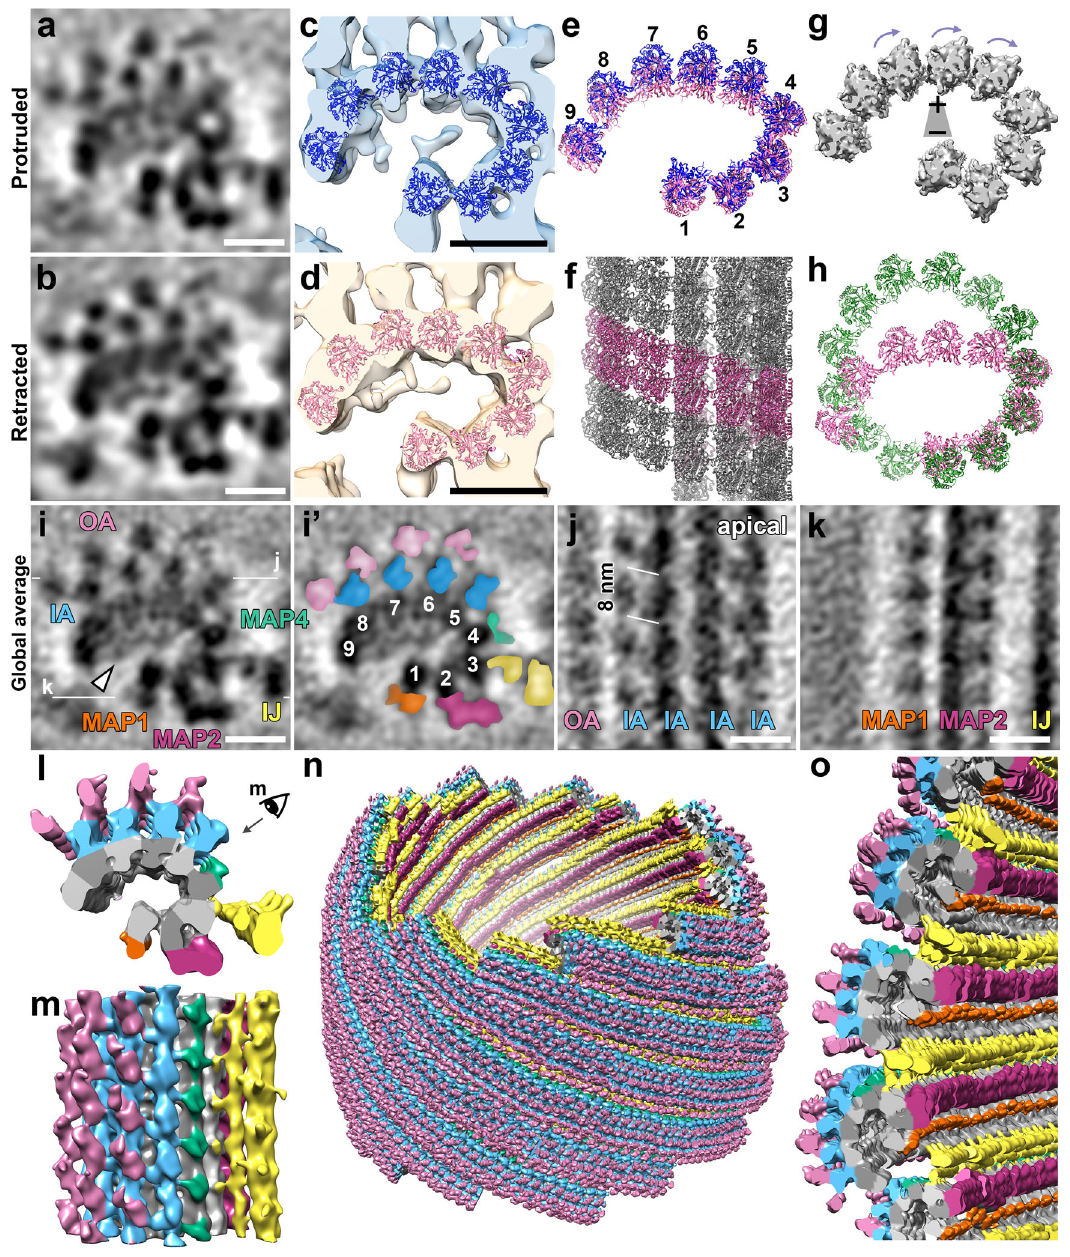
Fig. 4 | Subtomogram averages of the conoid fi bers show a C-shape archi- tecture with nine tubulin proto fi laments and associated proteins. a , b Cross- sectional tomographic slices of the averaged 8-nm repeats of the CF fi bers in the protruded( a )andretracted( b )states. c – e Thehigh-resolutionstructureoftubulin was fi tted into the subtomogram averages of the protruded ( c , blue) and the retracted ( d , pink) states. Comparison ( e ) of the two pseudo-atomic proto fi lament models in the protruded (blue) and retracted (pink) states shows no signi fi cant difference. f Longitudinal views of the pseudo-atomic proto fi lament model in the retracted state. The pitch was estimated based on the rise of the periodic CF- associated MAPs between neighboring proto fi laments. g Isosurface rendering of thenice-foldaveragedproto fi lamentsdisplaya “ clockwiseskew ” whenviewedfrom the conoid base, suggesting the minus ends of the conoid fi bers are orientated to the base. h The arrangements of the modeled proto fi laments in the CFs (pink) compared with the high-resolution cryo-EM structure of the typical 13- proto fi lament subpellicular microtubules (green; EMDB: EMD-23870). The most